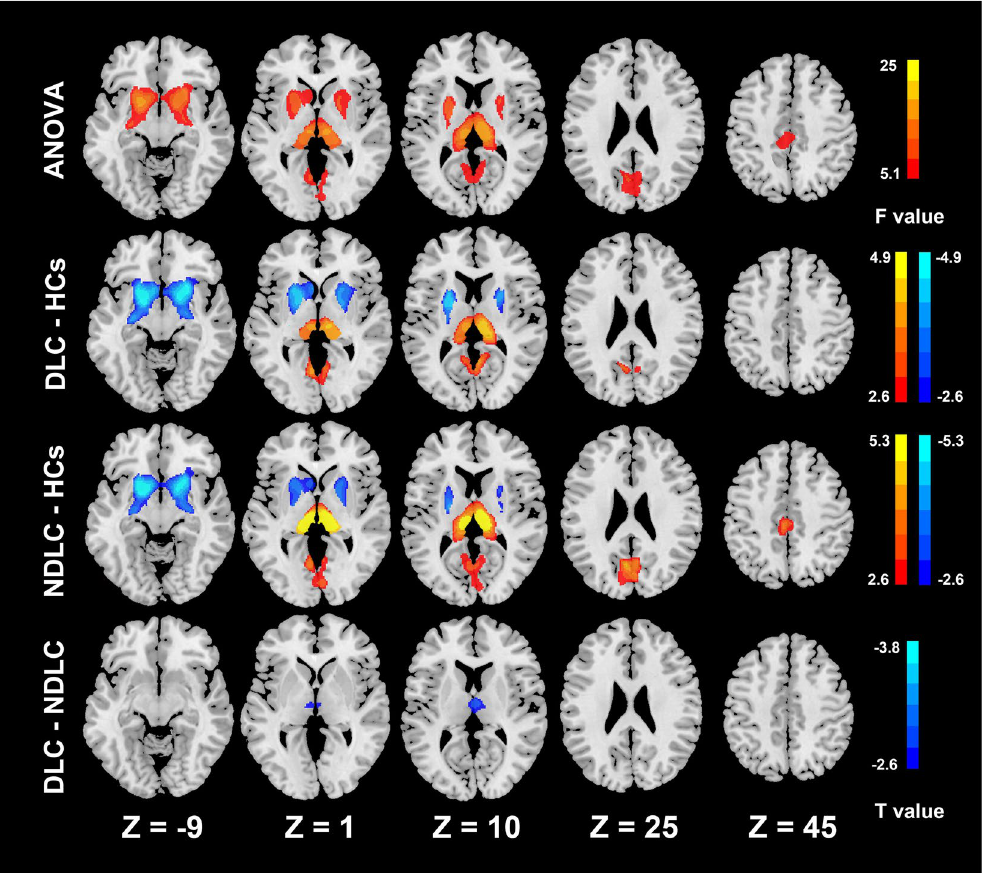
Figure 1. Group differences of gray matter volume. ANOVA analysis shows the volume of the putamen, thalamus, caudate, cuneus, calcarine, middle cingulate cortex and bilateral lingual gyri have significant differences among three groups. Compared with healthy controls, the diabetic cirrhosis patients group shows decreased volume in the caudate and putamen and increased volume in the thalamus and lingual gyrus. Non-diabetic cirrhosis patients group has decreased volume in the caudate and putamen and increased volume in the thalamus, middle cingulate cortex, cuneus and calcarines. The diabetic cirrhosis patients group has decreased volume in the thalamus compared with the non-diabetic cirrhosis patients group (all p < 0.05). ANOVA = analysis of variance, DLC = diabetic liver cirrhosis, NDLC = non-diabetic liver cirrhosis, HCs = healthy